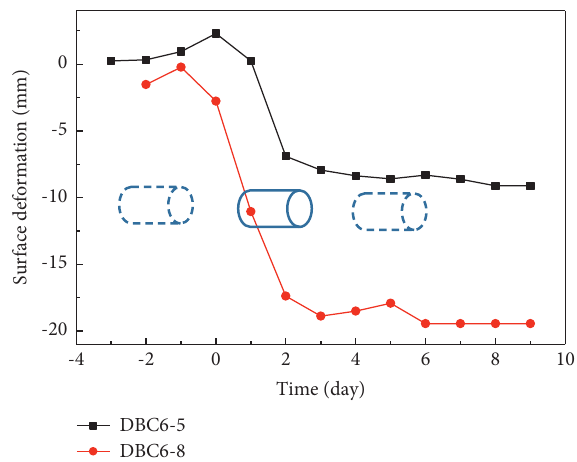
Figure 7: Deformation of monitoring points in section DBC6.